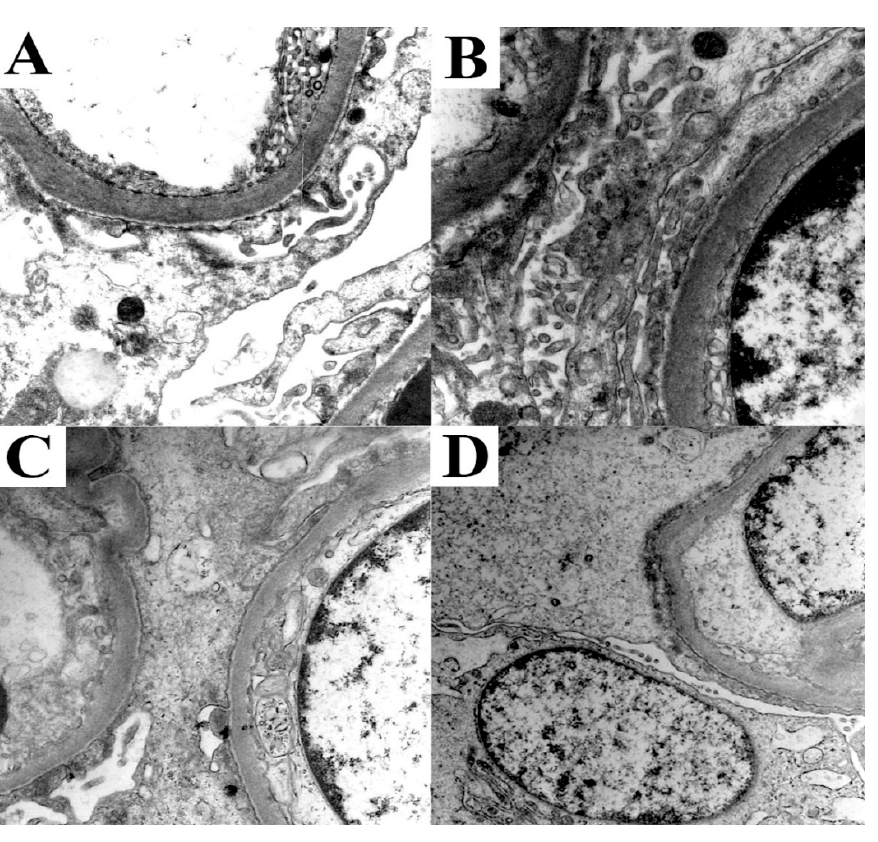
Figure 4. Ultrastructural features of MCD. Case 5 ( A ), Case 6 ( B ), Case 7 ( C ), and Case 8 ( D ) presented features of diffuse FPE.